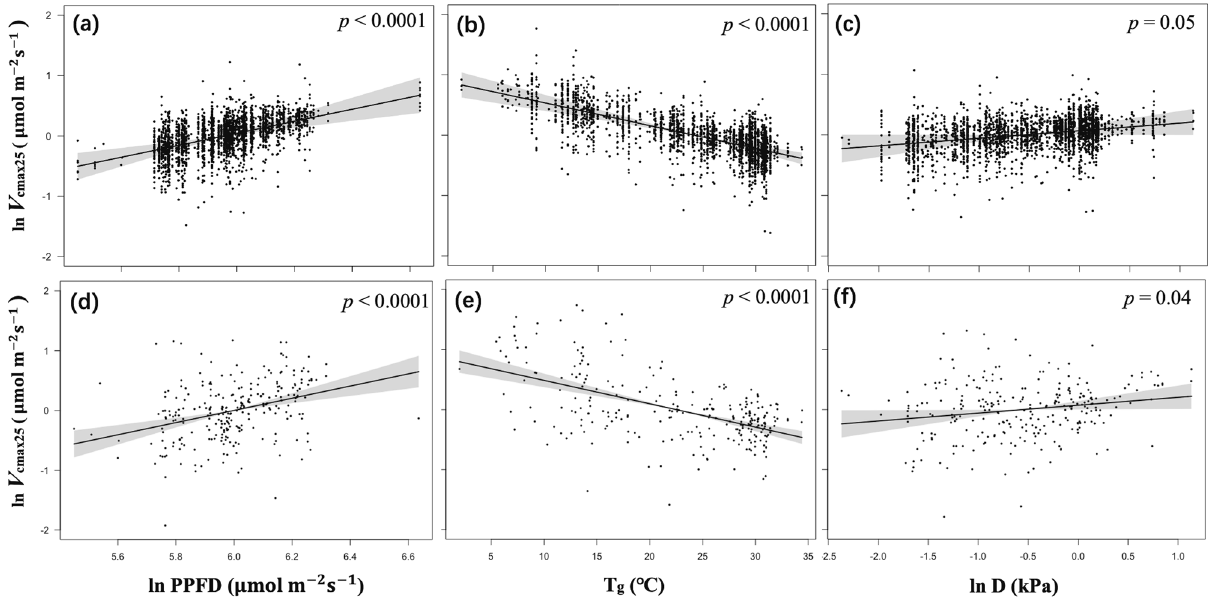
Fig. 1 Partial residual plots for V cmax25 in relation to climate variables. Partial residual plots for log-transformed V cmax25 : all-species ( a , b , c ) and site- means ( d , e , f ). Coef fi cients and standard errors for the fi tted lines are given in Supporting Information Table S4.